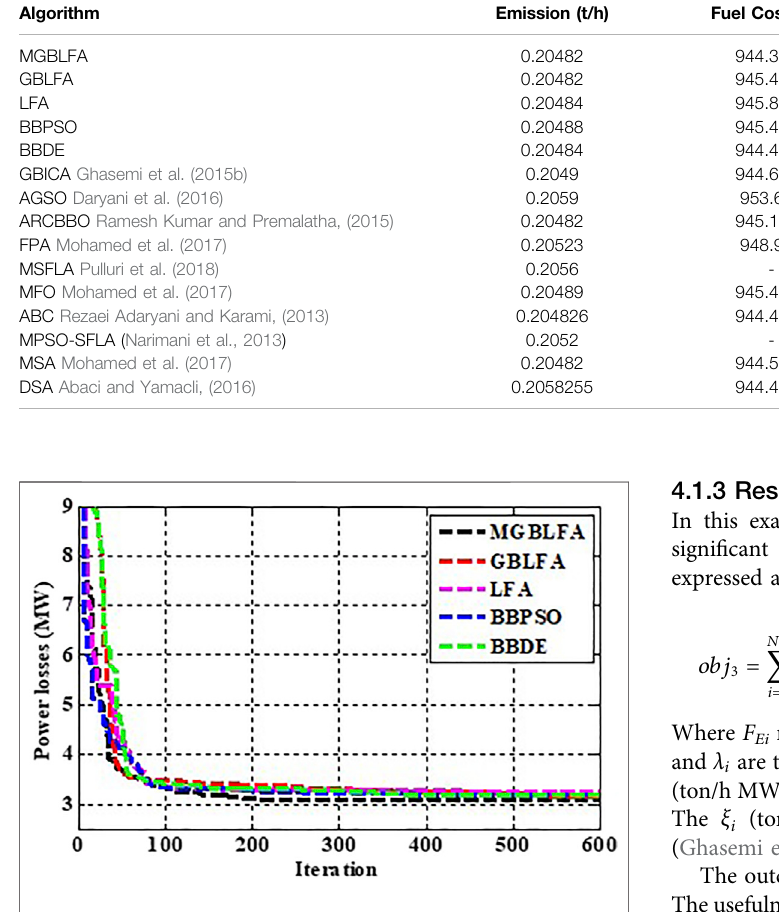
FIGURE 4 | Convergence characteristics of the algorithms for Case 3.